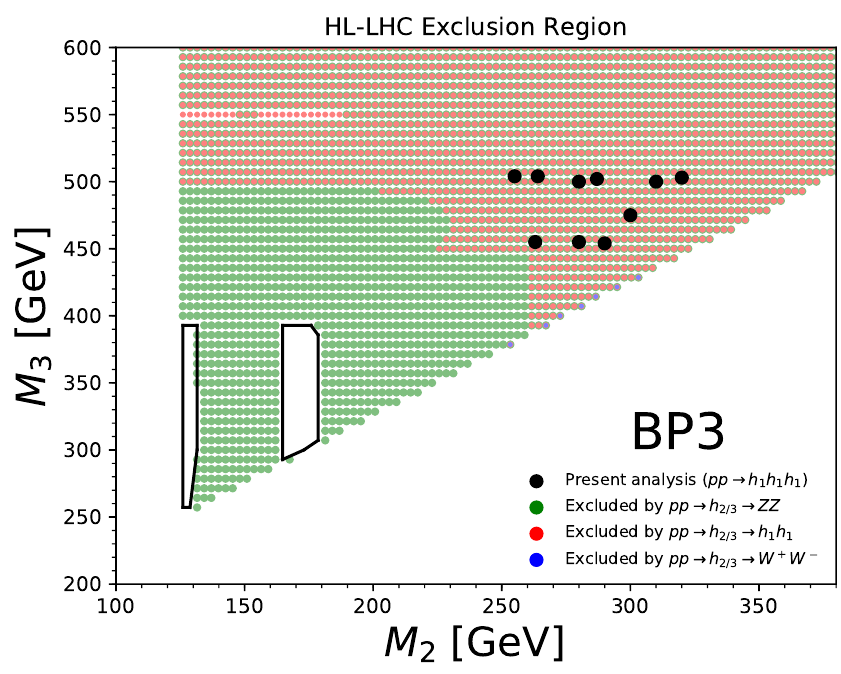
Figure 2 . The expected exclusion region for the full integrated luminosity of the HL-LHC, 3000 fb − 1 , through final states other than pp → h as explained in the main text. Points 1 h 1 h 1 with green circles are expected to be excluded by ZZ final states, with red circles by h and 1 h 1 with blue circles by W + W − . The W + W − analysis excludes only very few points on the parameter space and therefore appears infrequently in the figure. The points A – I that we have considered in our analysis of pp → h are shown in black circles overlayed on top of the circles indicating 1 h 1 h 1 the exclusion. The two cut-out white regions near M 130 GeV and M 170 GeV will remain 2 ∼ 2 ∼ viable at the end of the